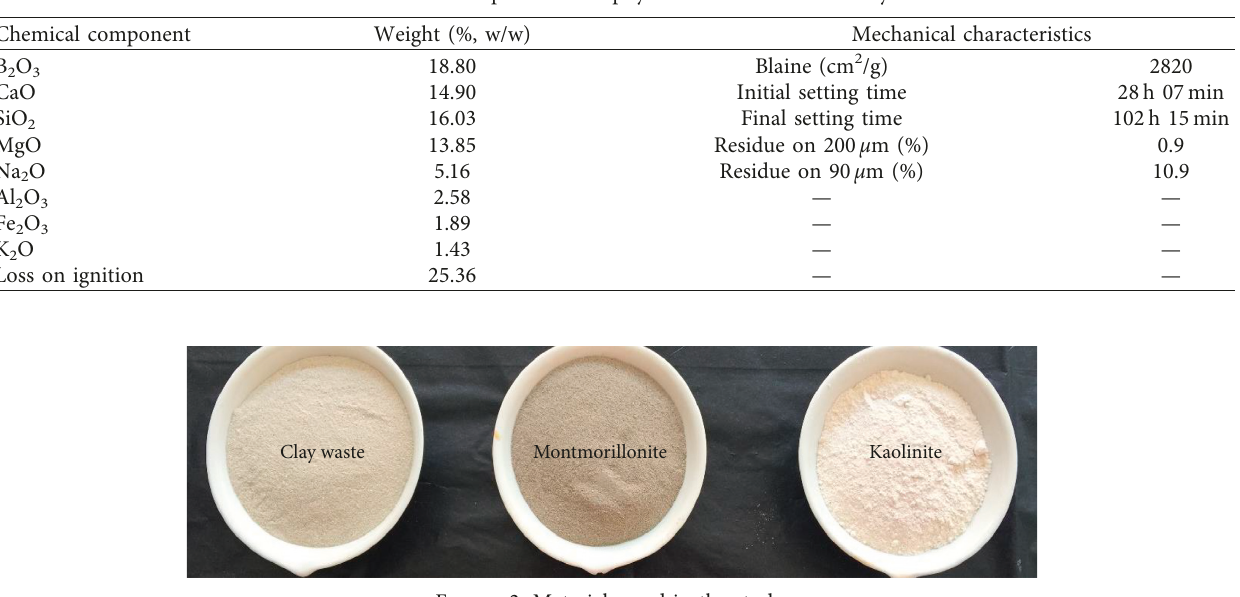
Figure 2: Materials used in the study. Table 2: Physical characteristics of the materials.